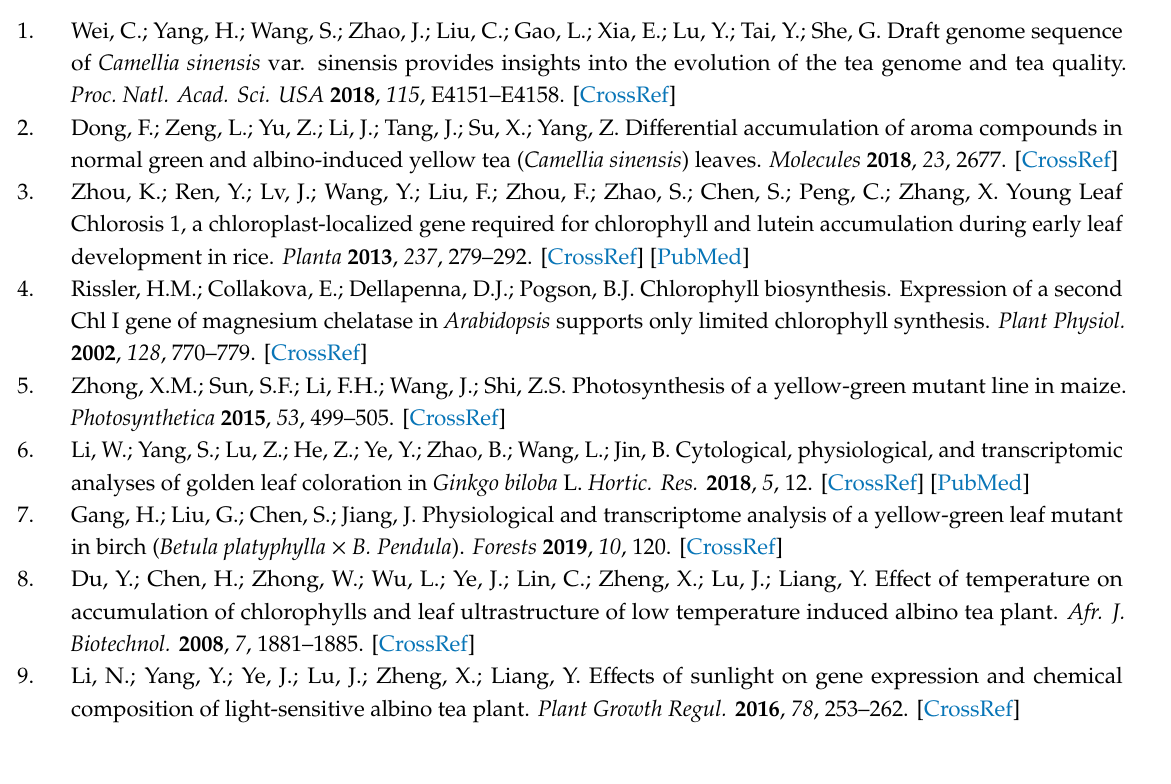
Figure S1: GO enrichment analysis of Di ff erentially expressed genes, Table S1: The primers for qRT-PCR, Table S2: Significantly changed metabolites in YR compared with GR, Table S3: Di ff erentially expressed genes in YR compared with